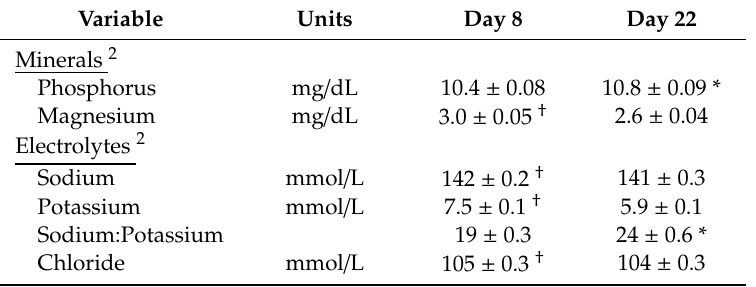
Table 4. Serum chemistry variables that di ff ered significantly between day 8 and day 22 independent of 6 (cid:48) -SL sodium salt